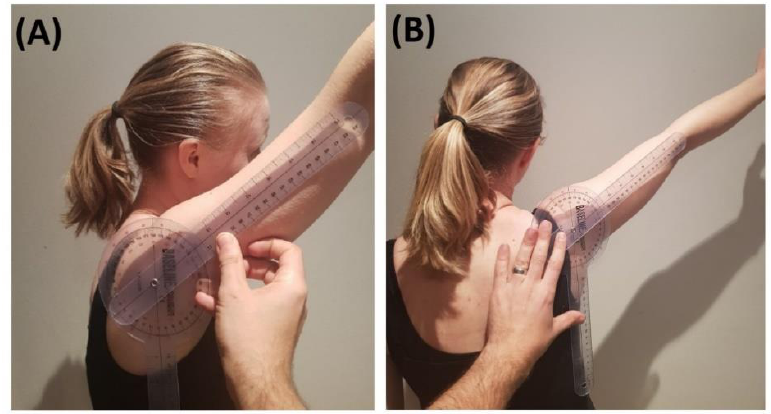
Figure 3. Goniometry measurement. ( A ) Forward flexion. ( B ) Abduction.